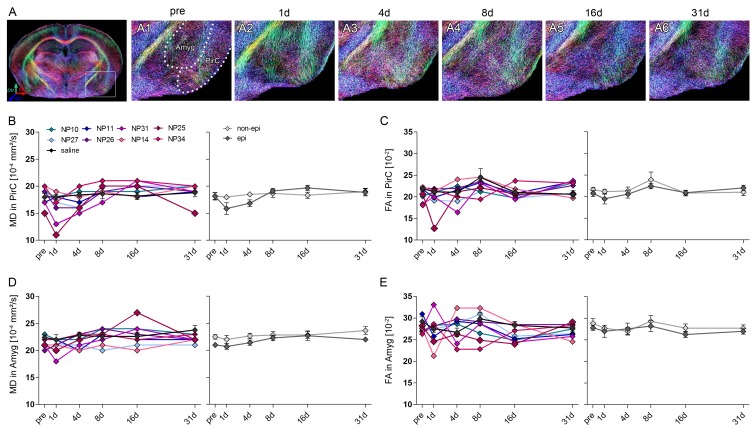
DWI changes in the piriform cortex and the amygdala during epileptogenesis.(A) Representative coronal section of diffusion-weighted tractography images before injection. White box denotes the location of the amygdala (Amyg) and the piriform cortex (PirC). (A1-6) Enlarged tractography images of the piriform cortex (PirC) and the amygdala (Amyg) at different time points during epileptogenesis in the same animal (before injection, pre and 1d, 4d, 7d, 14d and 31d following SE). Scale bar: 50 µm. (B–E) Quantitative analysis of the mean diffusivity (MD) and fractional anisotropy (FA) in the piriform cortex and the amygdala, respectively. Values are plotted for individual mice (left panel; controls, black, n = 5; kainate-injected animals color-coded) and for groups (right panel; epileptic, dark grey; non-epileptic, light grey) during epileptogenesis. Two-way ANOVA, Bonferroni’s post-test, nnon-epi = 6, nepi = 7. Values are presented as the mean ± SEM.